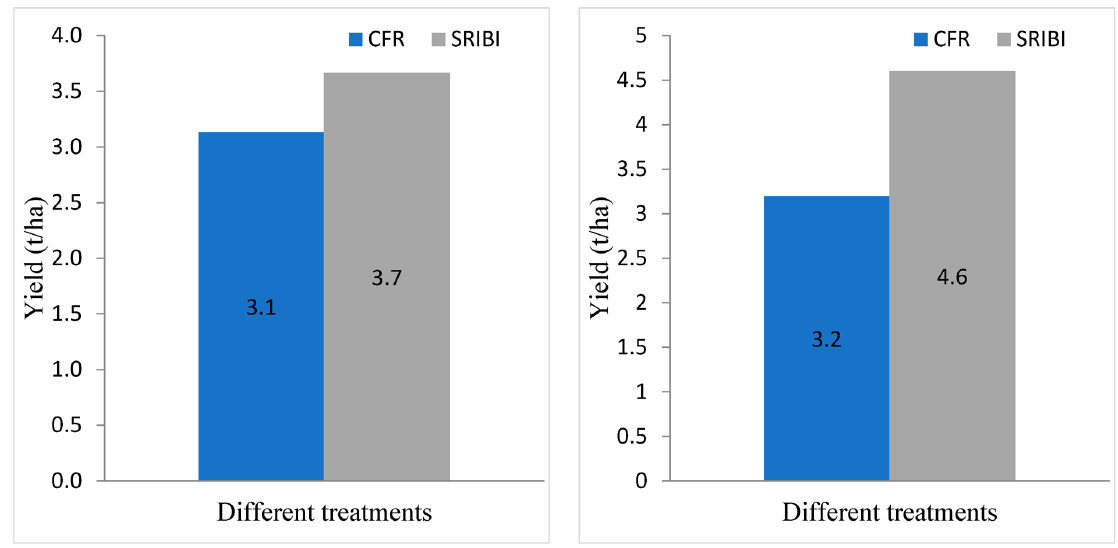
Figure 7. Yield observed in the different treatments ( Left : 2019; Right : 2020).